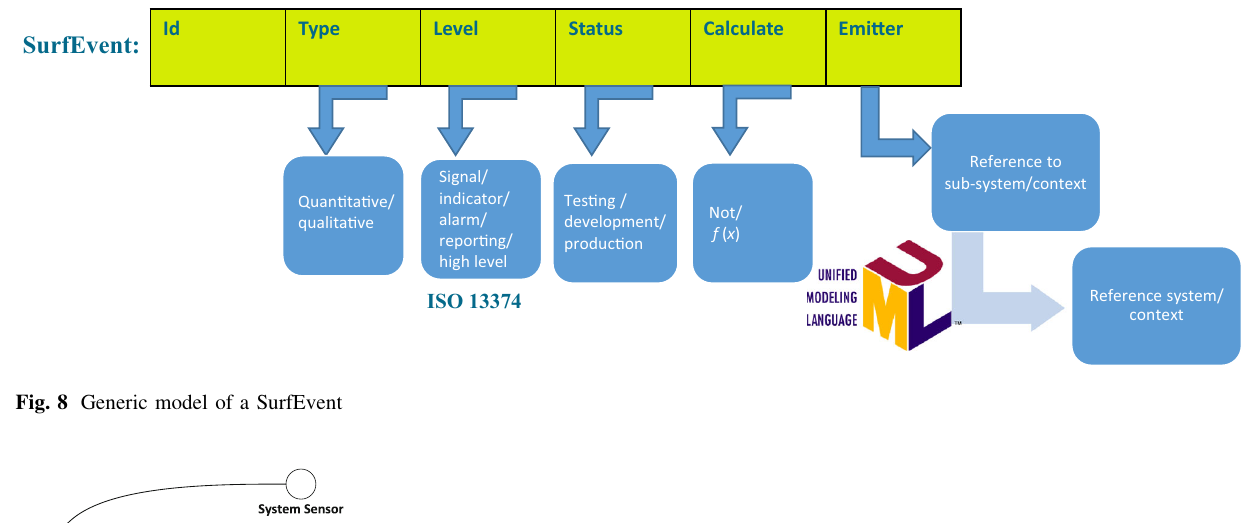
Fig. 8 Generic model of a SurfEvent